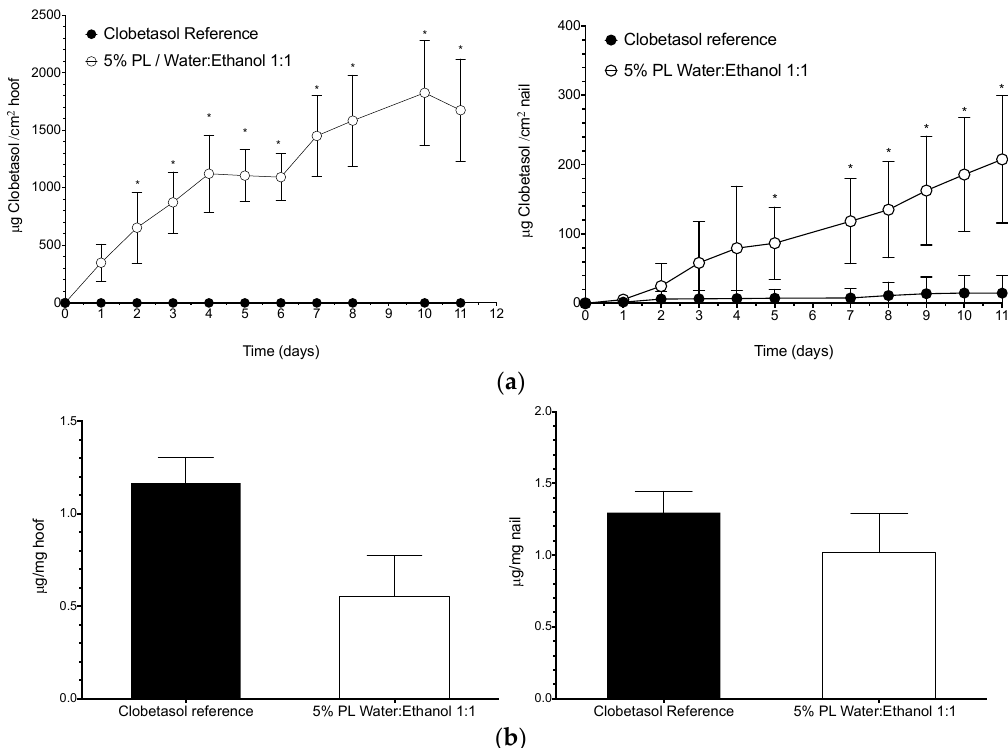
Figure 9. (mean ± SD, n = 3) ( a ) Top panels: Permeation profiles of clobetasol propionate and ( b ) Bottom panels: Amount of drug recovered from nail or bovine hoof after the eleven days of permeation study. In both cases, the left panels show the results for bovine hoof and the right panels the results obtained with human nail clippings. In both models, the lacquer made with 5% Poloxamer 407 and a 1:1 water:ethanol mixture and the reference lacquer containing 8% of clobetasol propionate in Uñabase (see text and Material and Methods) were compared. Stars indicates significant differences with the other lacquers (two-way ANOVA, Tukey post-hoc test, α < 0.05).